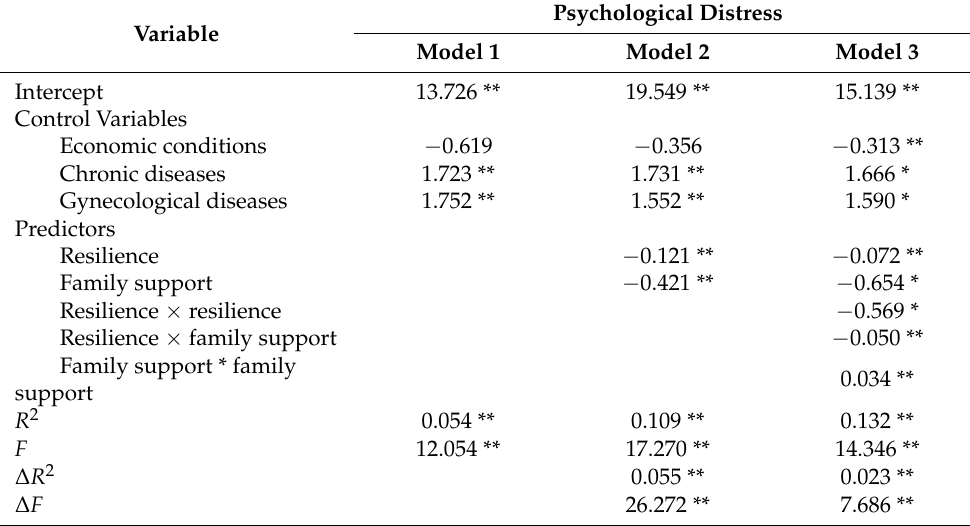
Table 4. Polynomial regression results for the effects of resilience and family support.